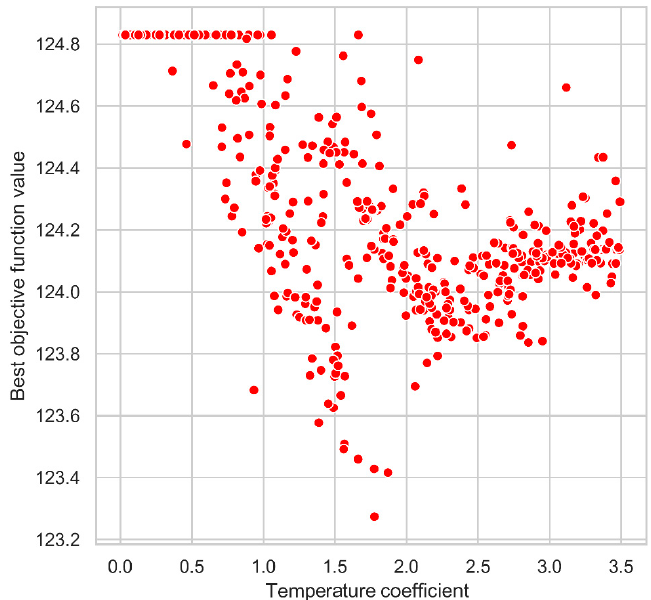
Figure 8. A dot plot diagram of the probabilistic dependence of the resultant objective function values 𝜑(𝑥̅) collected using the very fast simulated annealing method upon the temperature coefficient 𝐶 .